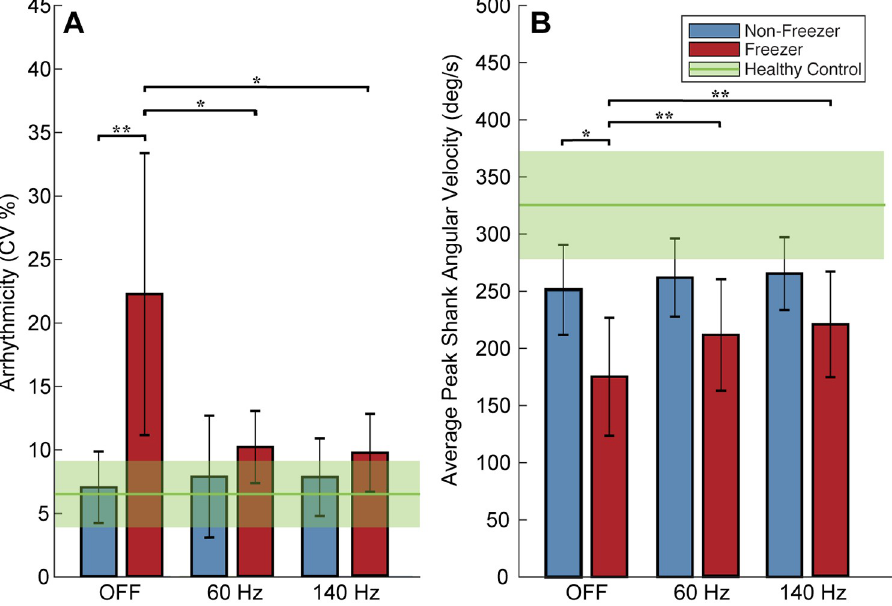
Fig 7. Gait arrhythmicity and average peak shank angular velocity OFF and during 60 Hz and 140 Hz deep brain stimulation (DBS). A: Gait arrhythmicity and B: average peak shank angular velocity during stimulation conditions. Healthy control averages shown (green line) with standard deviations (shaded green). Error bars represent standard deviation. � denotes p < 0.05, �� denotes p <